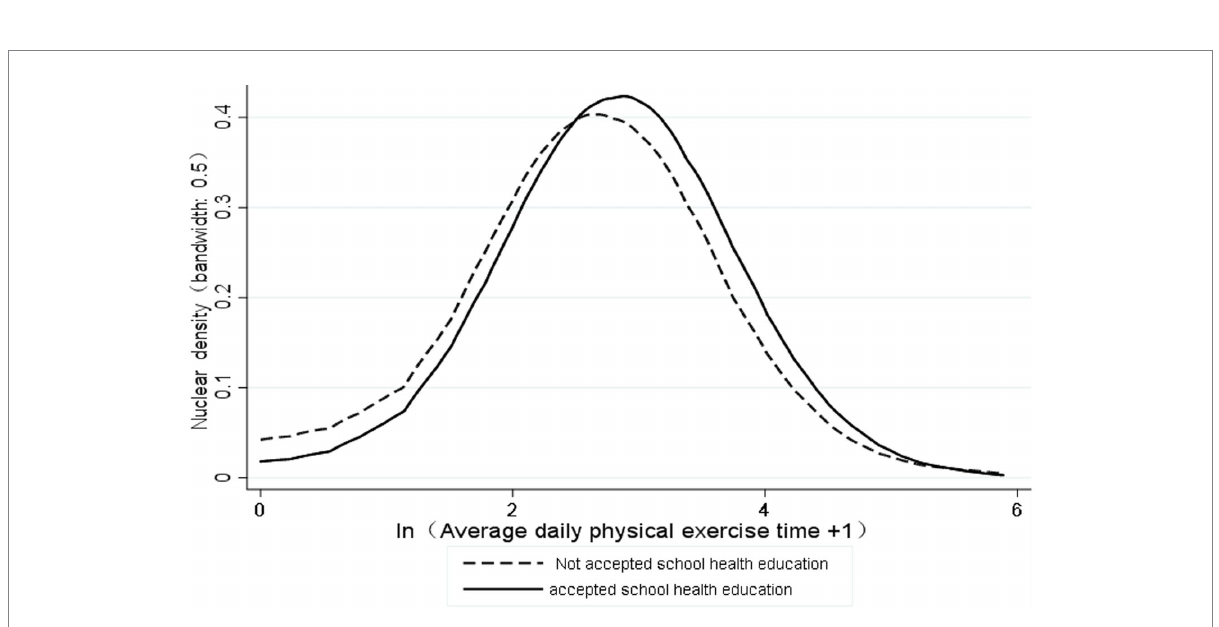
FIGURE 2 Distribution of kernel density estimates for average daily physical exercise time.